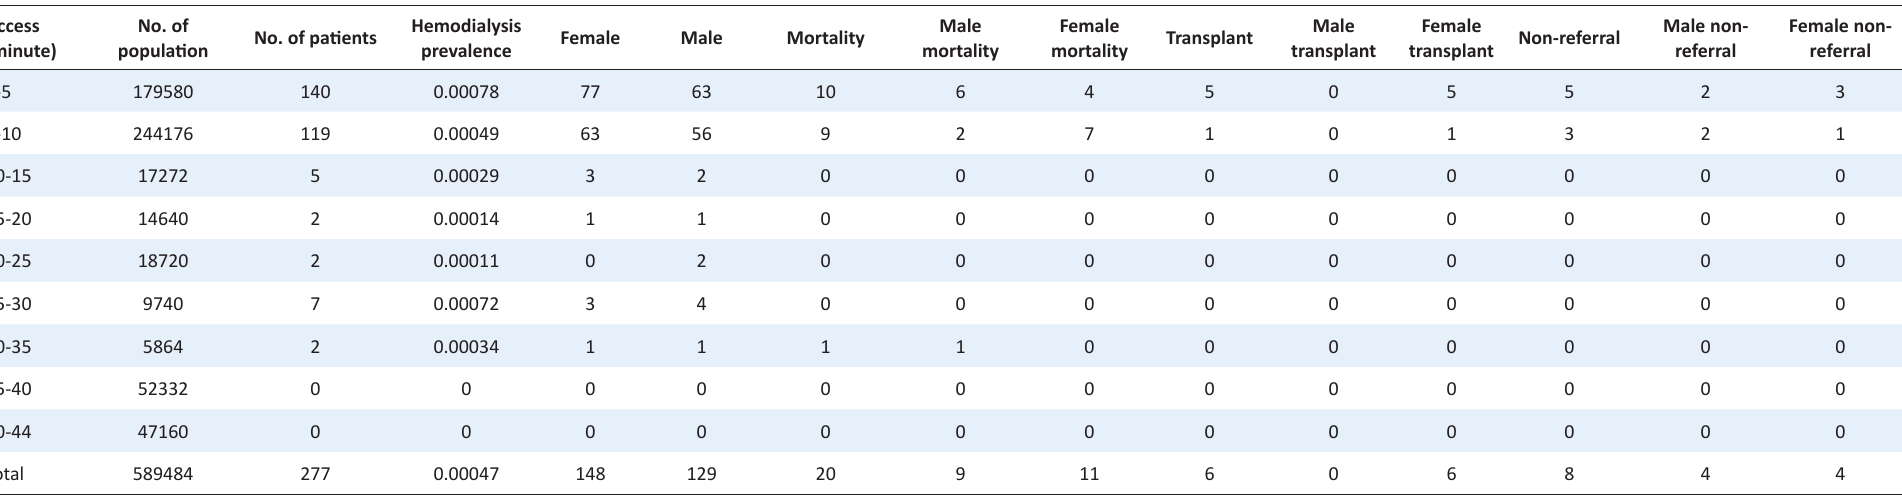
Table 1. Accessibility of patients and residents to the hemodialysis center and the number of mortality, kidney transplant Access (minute)